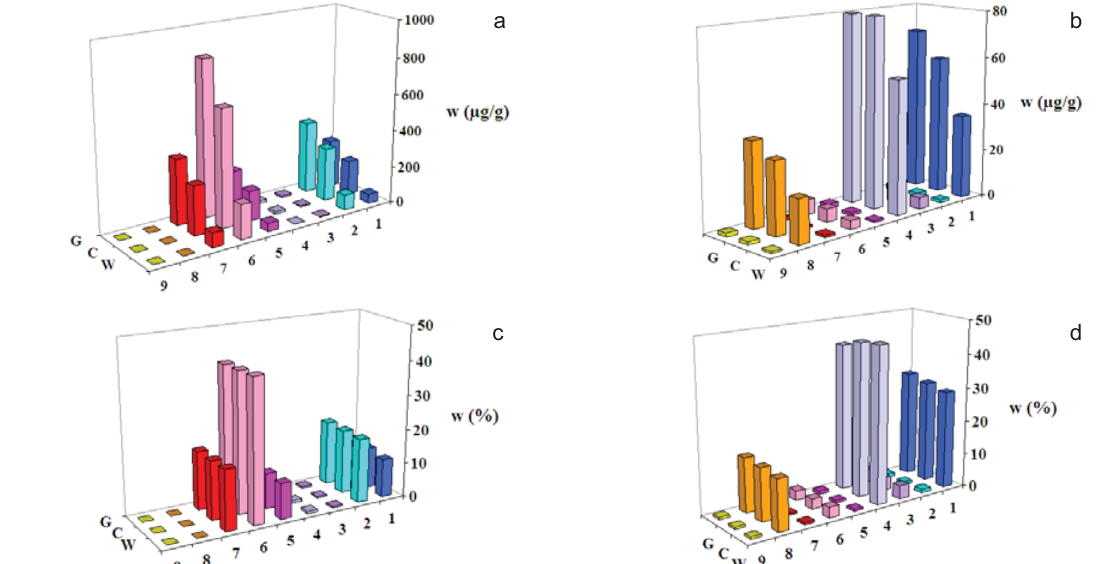
Figure 3. The effect of sample preparation method on the amount (a, b) and representation (c, d) of monoterpenes in needles P. pungens and leaves J. regia L